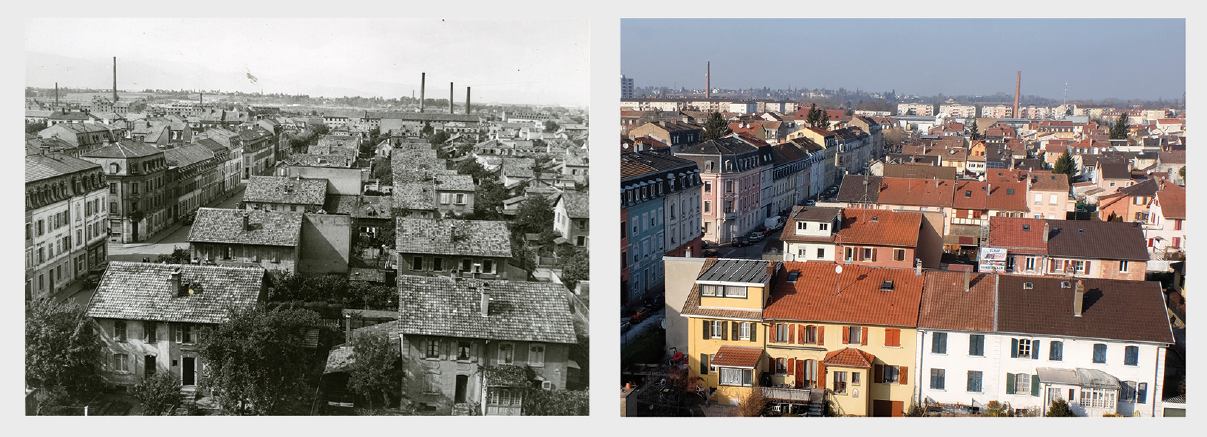
Figure 1. View of the western part of Cité Ouvrière (Rue des Oiseaux) from the bell tower of Saint‐Joseph church in 1901 (left) and 2017 (right), photographed using the same vantage point. Source: Archives de Mulhouse collection (left) and Luc Georges (right); edited by the